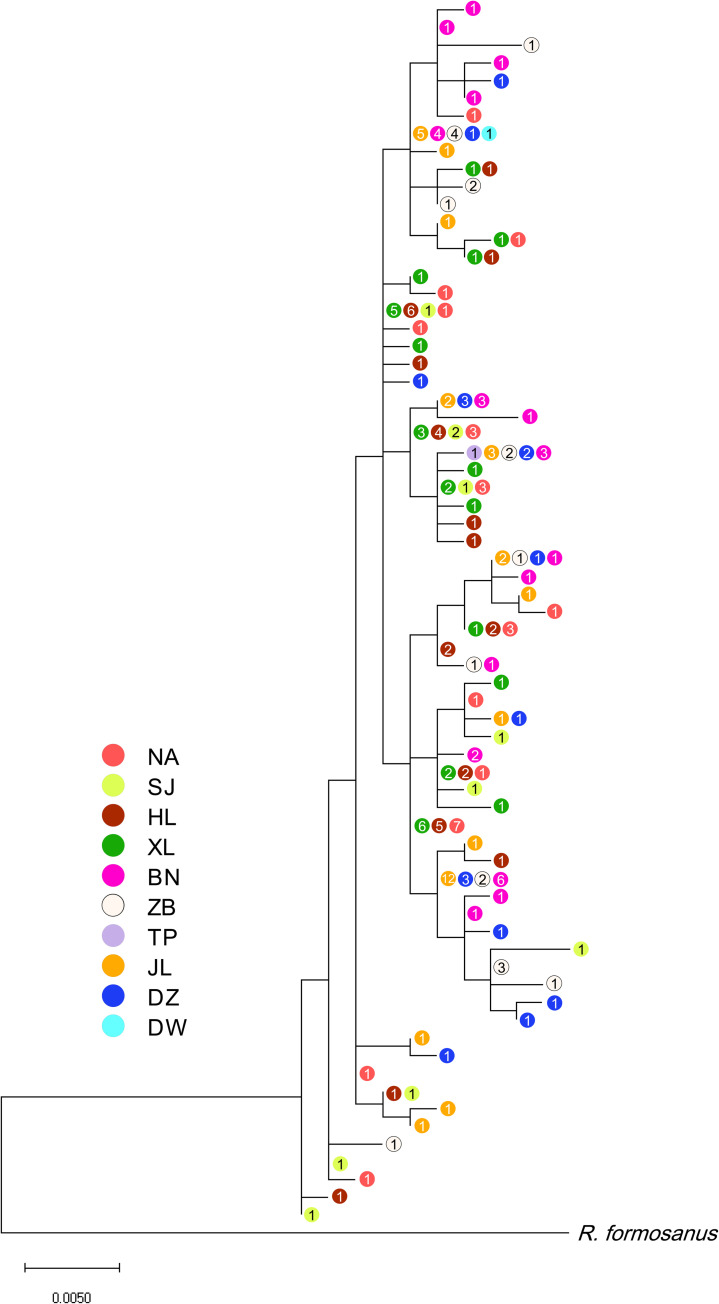
The maximum likelihood tree for Rhinogobius gigas.Based on haplotypes of 191 concatenated mtDNA sequences (1074 bps). Bootstrap values of all nodes are lower than 55 and not shown. Colors represent different sampling basin; numerals within circles represent number of individuals; basin names of codes are given in Table 1.